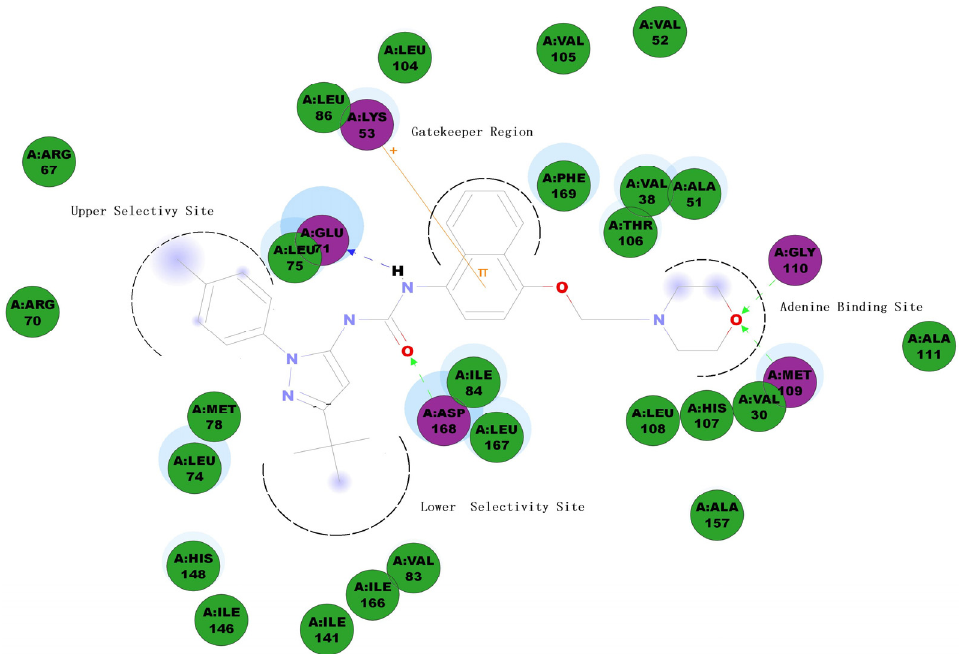
Figure 1. Structure of the compound BIRB796 and two-dimensional p 38 MAPK α /BIRB796 interaction